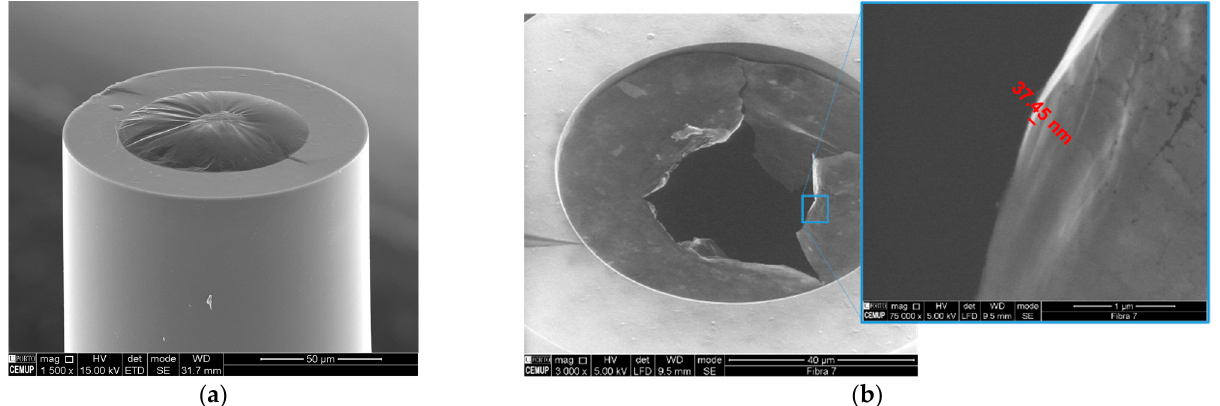
Figure 2. SEM image of a ( a ) sealed GO membrane and ( b ) a ruptured GO membrane and respective thickness